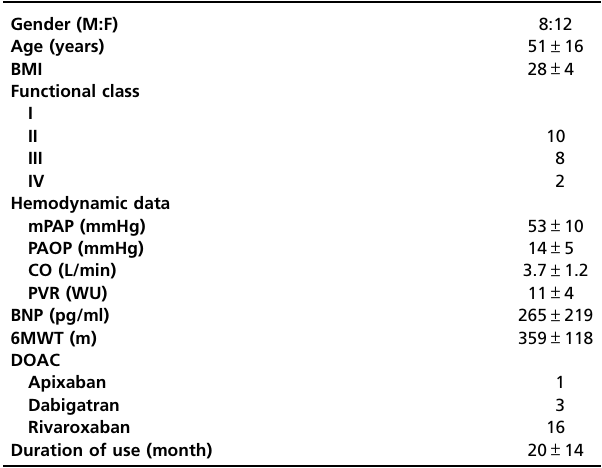
Table 1 - Patient demographic and clinical